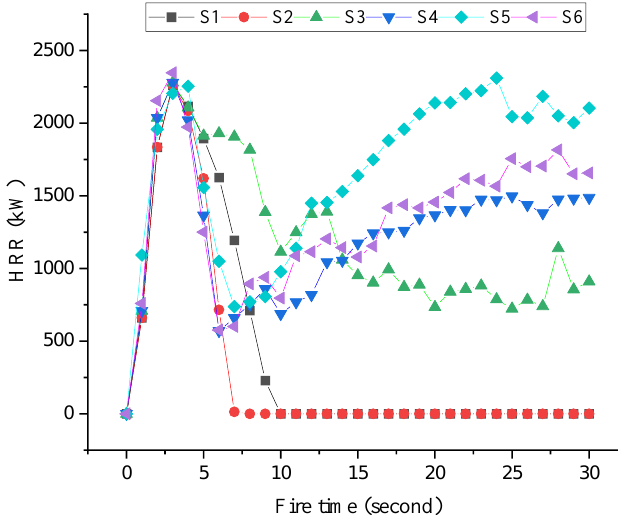
Figure 21. Heat release rate over time.